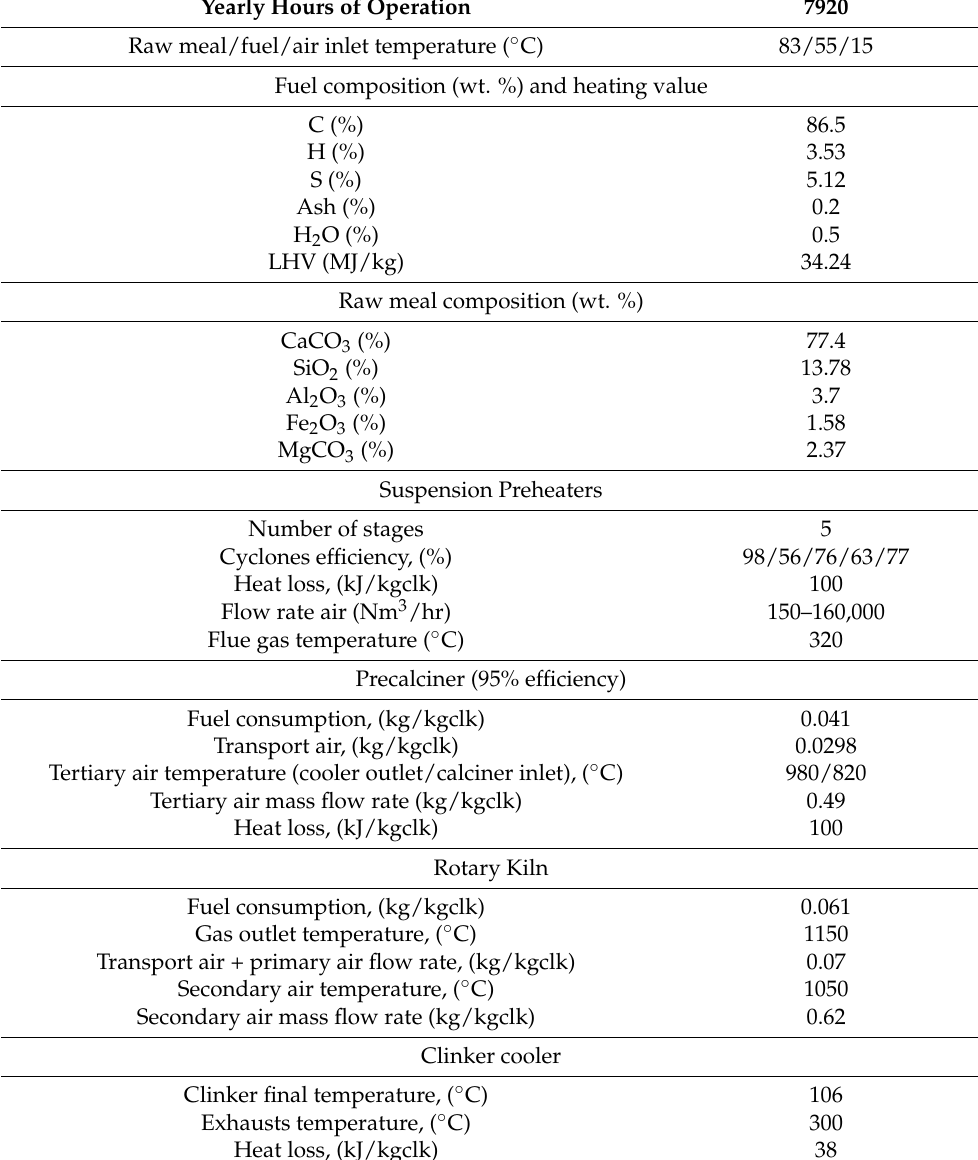
Table 1. Technical data of Colacem clinker production plant in Gubbio, Italy for reference year